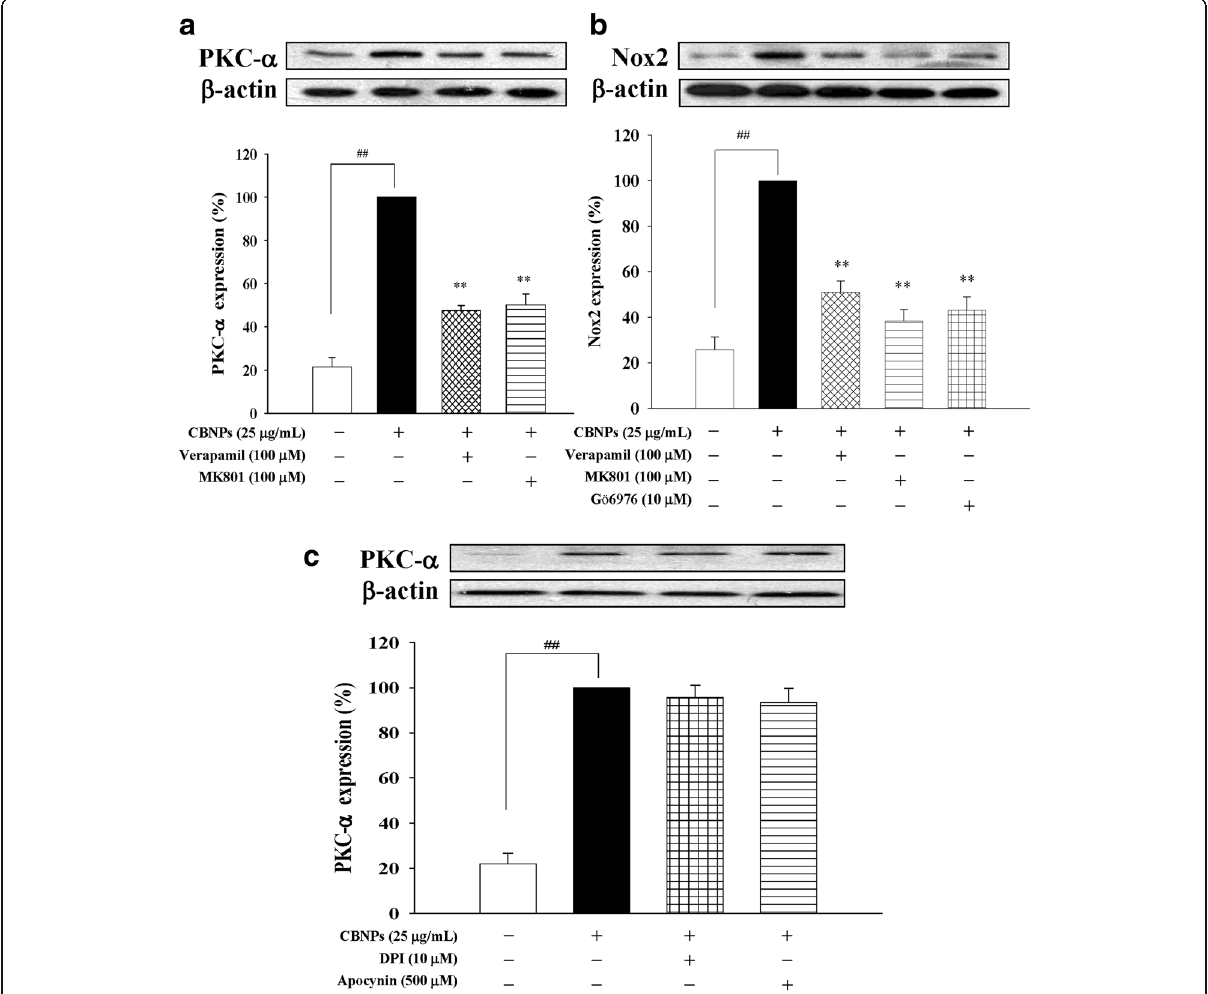
Fig. 4 a Effects of verapamil or MK801 on CBNPs-induced PKC- α activation in A549 cells. b Effects of verapamil, MK801, or Gö6976 on CBNP- induced Nox2 activation in A549 cells. c Effects of DPI or apocynin on CBNPs-induced PKC- α activation in A549 cells. Cell were pretreated with verapamil, MK801, Gö69761, DPI, or apocynin for 1 h, respectively, and then treated with CBNPs (25 μ g/mL) for 1 h or 24 h for determination of PKC- α and Nox, respectively. Bars represent the mean ± S.E.M. from six independent experiments. ## P < 0.01 vs. control group (without any treatment). ** P < 0.01 vs. CBNPs (25 μ g/mL)